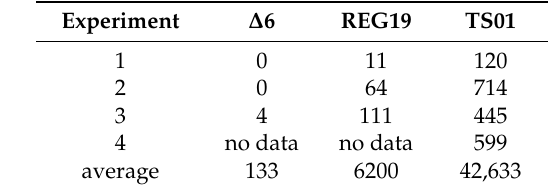
Table 1. Transformation efficiency of the B. subtilis strains ∆ 6, REG19, and